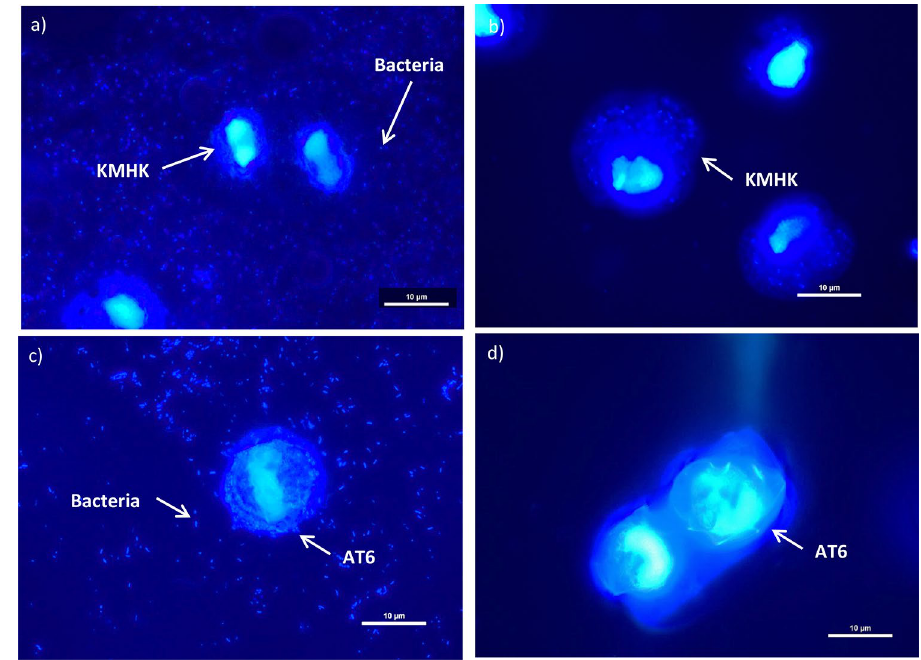
Figure 4. DAPI epifluorescence microscopic images of KMHK and AT6 samples under ×1000 magnification: ( a ) untreated (control) and ( b ) treated KMHK samples; ( c ) untreated (control) and ( d ) treated AT6 samples.